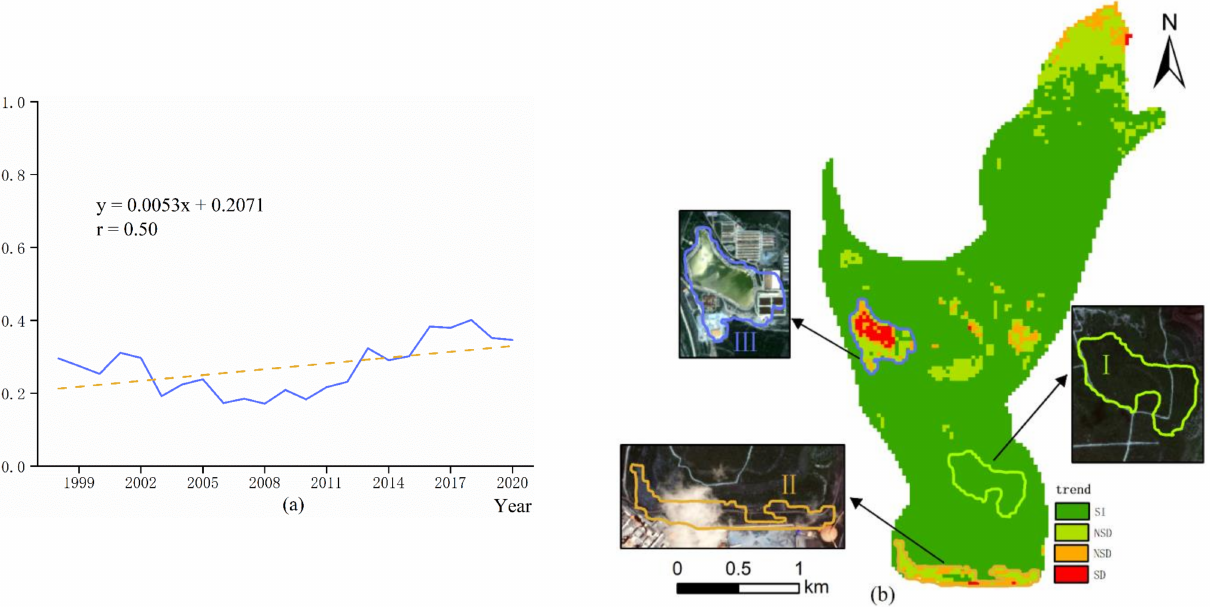
Figure 9. The time series analysis for NDVI on time and spatial scales in the inner dump. ( a ) shows the results of the unary regression analysis. And ( b ) shows the results of the Sen+MK trend analysis. SI, NSI, NSD, and SD are, respectively, the abbreviations for significantly increased, not significantly increased, not significantly decreased, and significantly decreased.